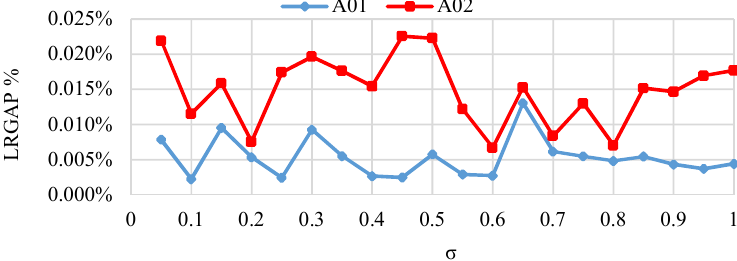
Fig. 6 . Sensitivity analysis of the LRGAP % to σ for small-sized instances.